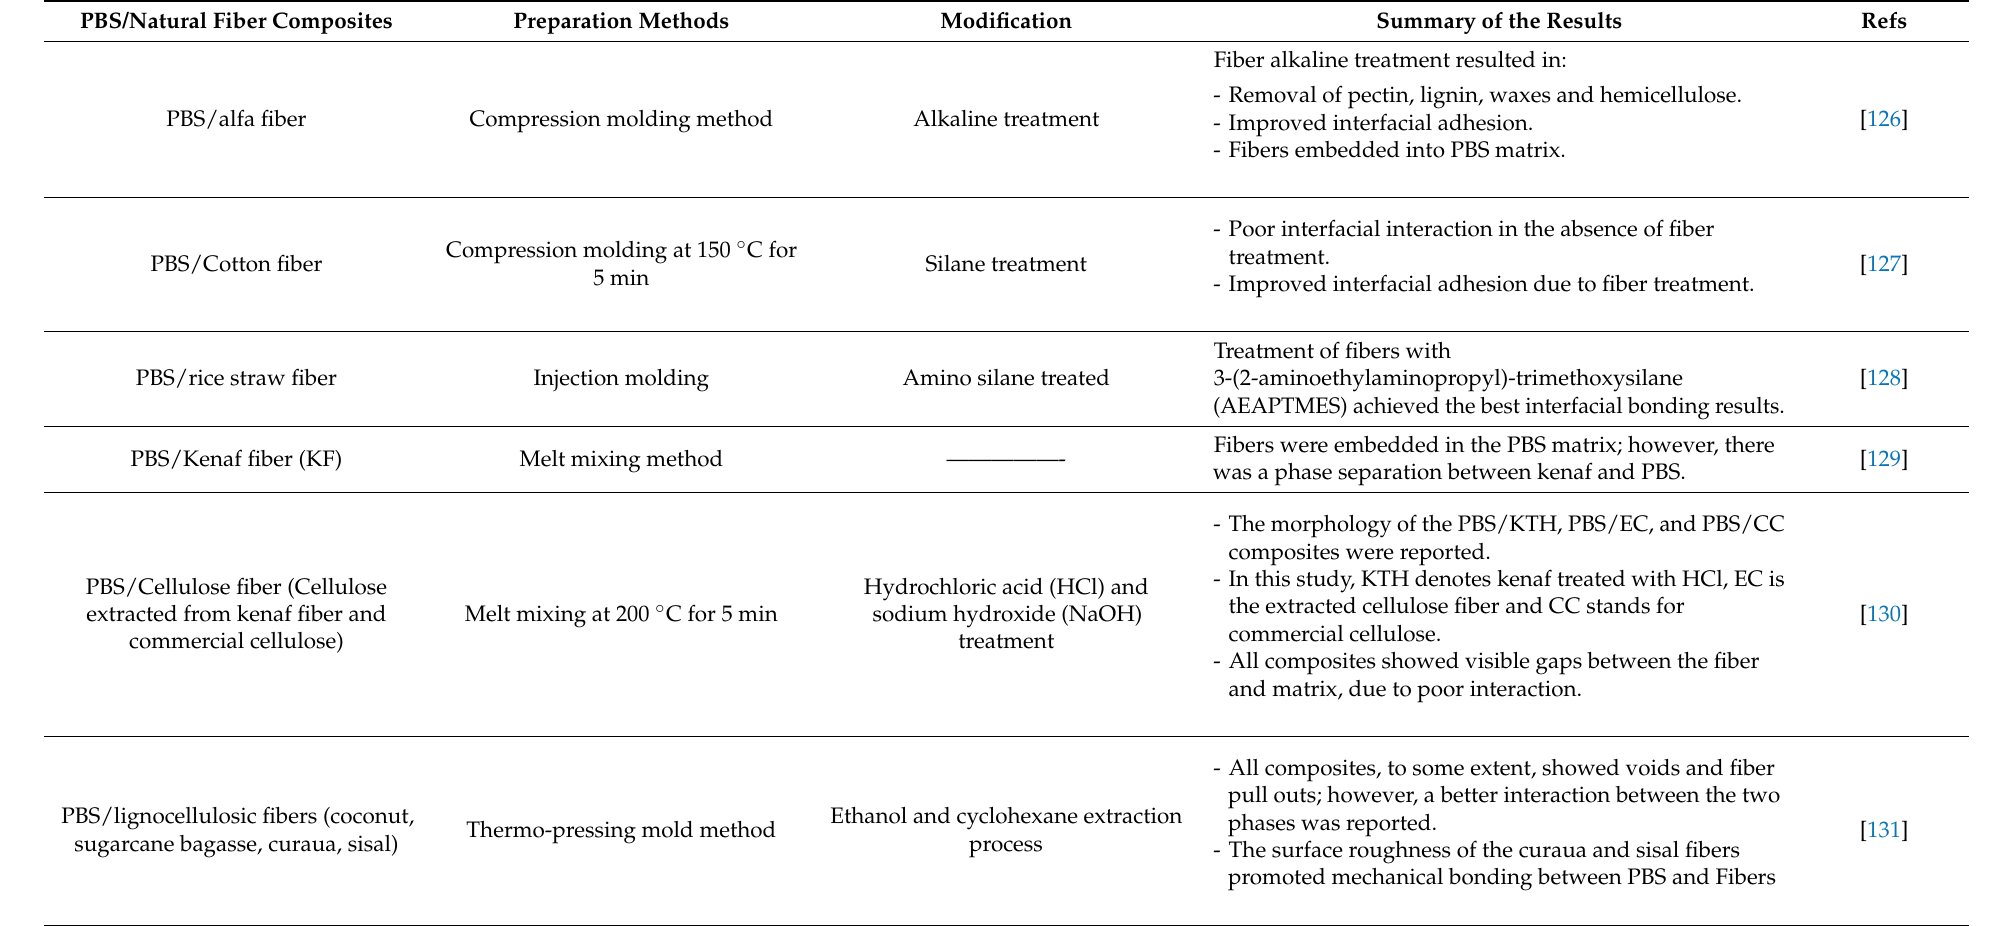
Table 4. Summary of selective studies on the preparation, modification and morphology of natural fiber-reinforced